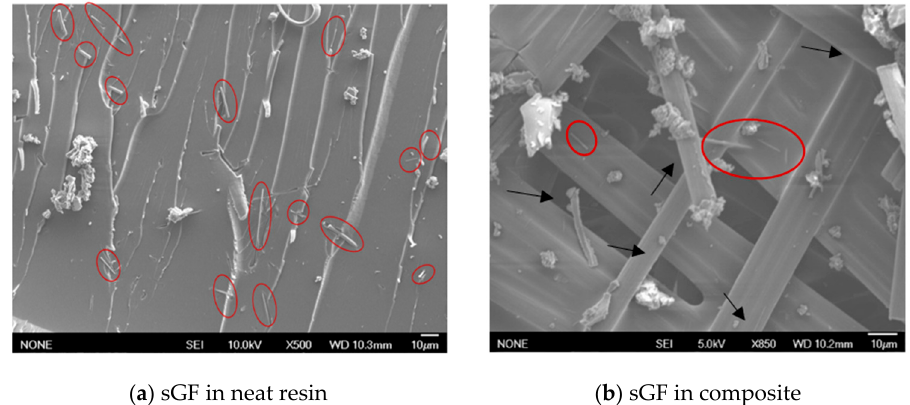
Figure 5. The dispersion of glass fiber (marked by cycles) in resin matrix and in composite reinforced by 3 mm carbon fiber (pointed out by arrows).